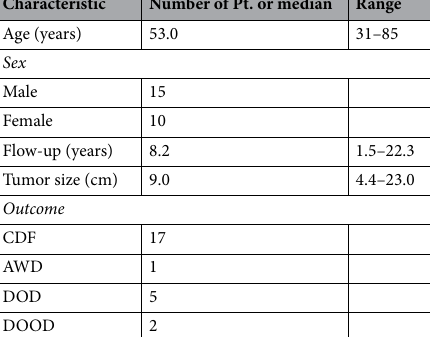
Characteristic Number of Pt. or median